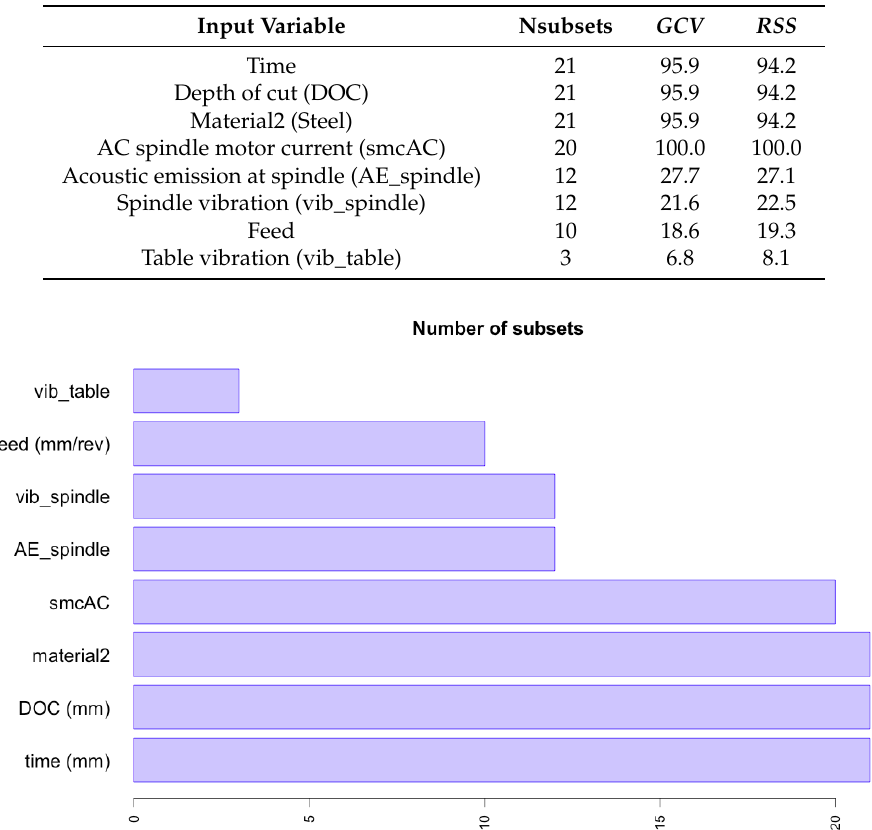
Figure 8. Relative importance of the input operation variables to predict the tool flank wear (VB) in the fitted ABC-MARS-based model.